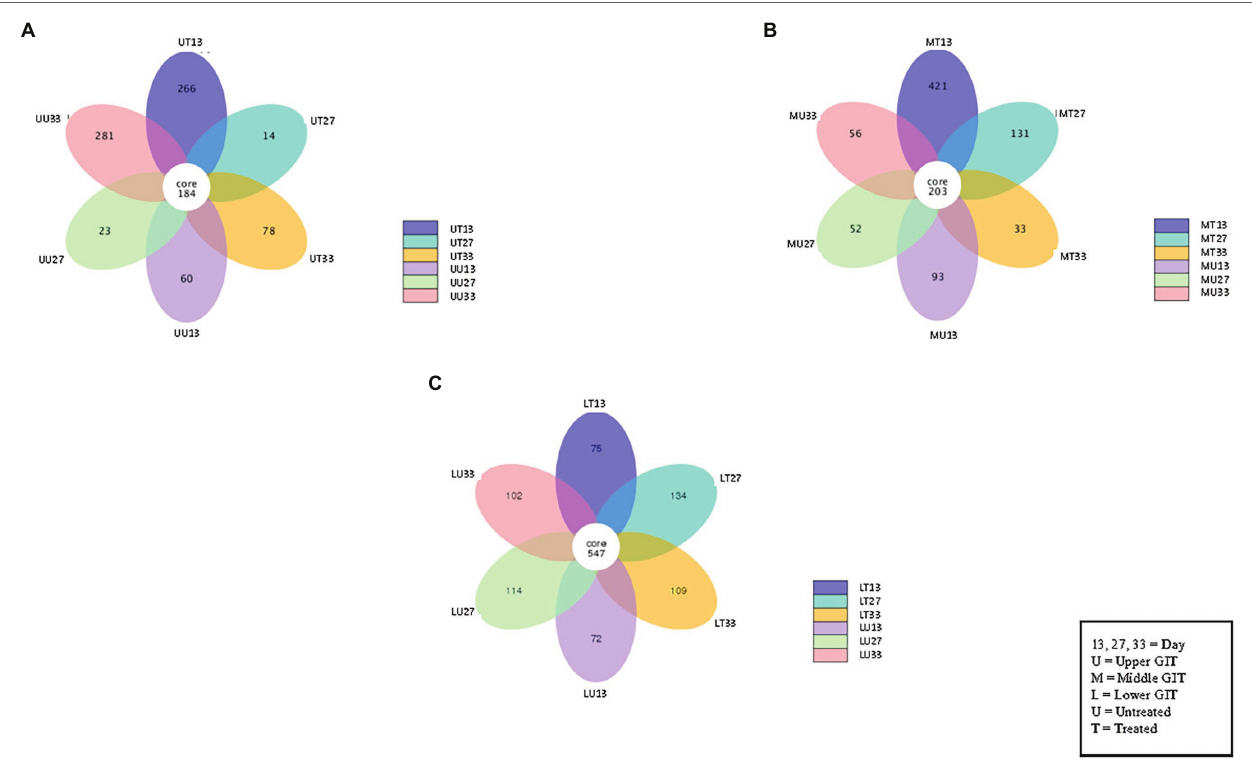
FIGURE 3 | Flower Venn diagram depicting the shared and unshared OTUs between for the upper (A) , middle (B) and lower (C) GIT samples at each time point. Each petal represents a single sample group at a single time point. The number inside each petal represents the number of unique OTUs for that